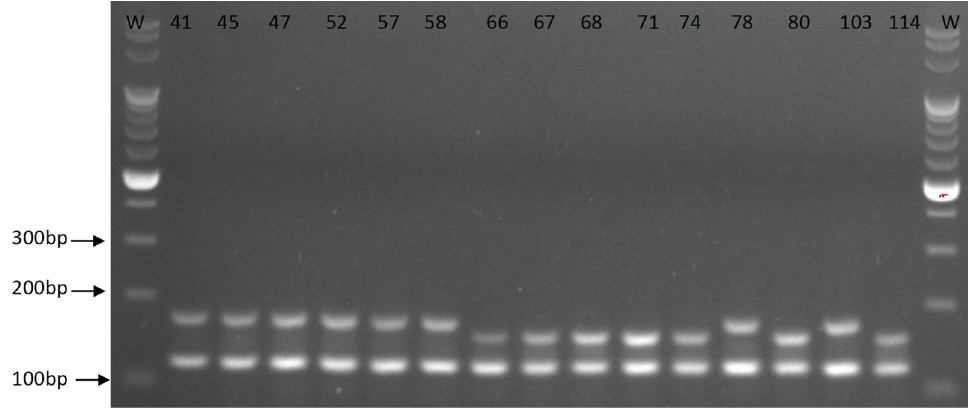
Figure 8. Electrophoretic image of PCR products after including bnlg1621 and umc2059 primer pairs in the reaction.